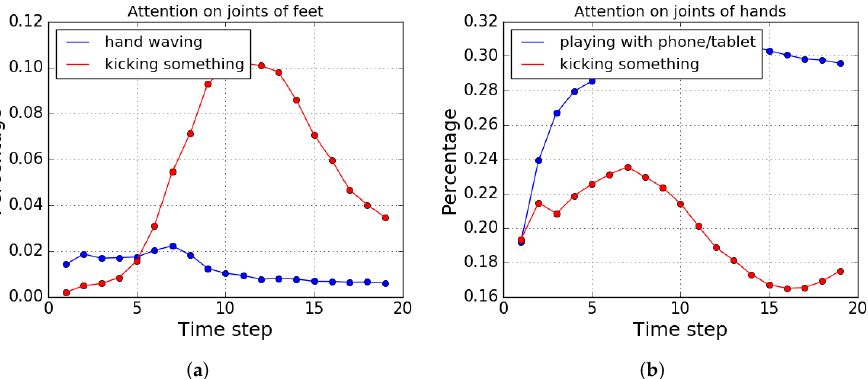
Figure 5. Compasion of the attention on the joints of feet and hands over time for different action classes. ( a ) Progress of the attention on the joints of feet over time for “hand waving” and “kicking something”. ( b ) Progress of the attention on the joints of hands over time for “playing with phone/tablet” and “kicking